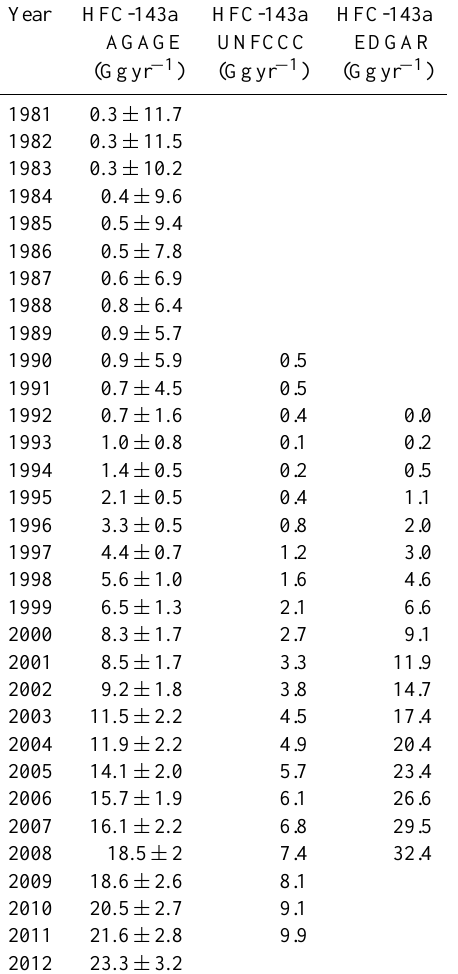
Table 2. Estimates of global emissions of HFC-143a (Ggyr − 1 ) based on AGAGE in situ measurements and archived air samples (the NH flasks were collected primarily at Trinidad Head and the SH flasks at Cape Grim) using the AGAGE 2-D 12-box model. Es- timates of total emissions prior to November 2003 are based only on archived air samples. Also shown are 5-year averaged global emis- sion estimates derived by Culbertson et al. (2004), global emission estimates derived from UNFCCC National Inventory Reports (2012 submission), and from the EDGAR (v4.2) database.